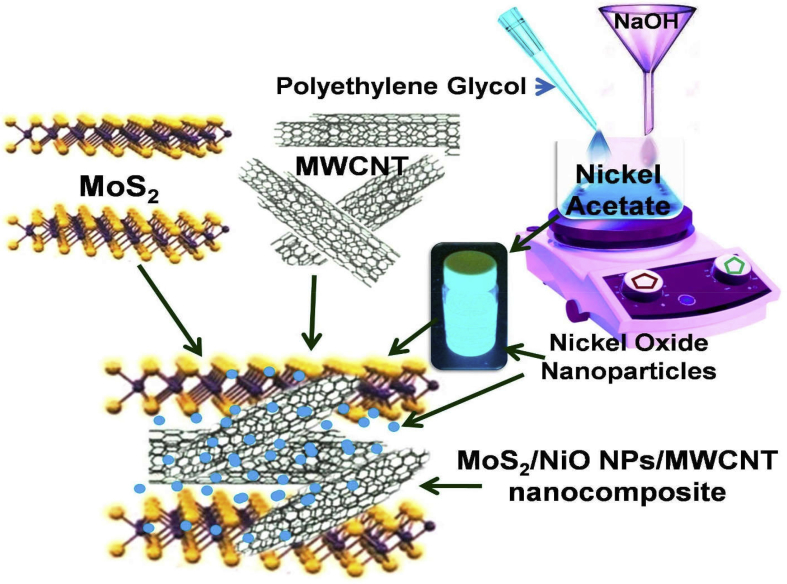
Schematic illustration for the synthesis of MoS2/NiO NPs/MWCNT nanocomposite.